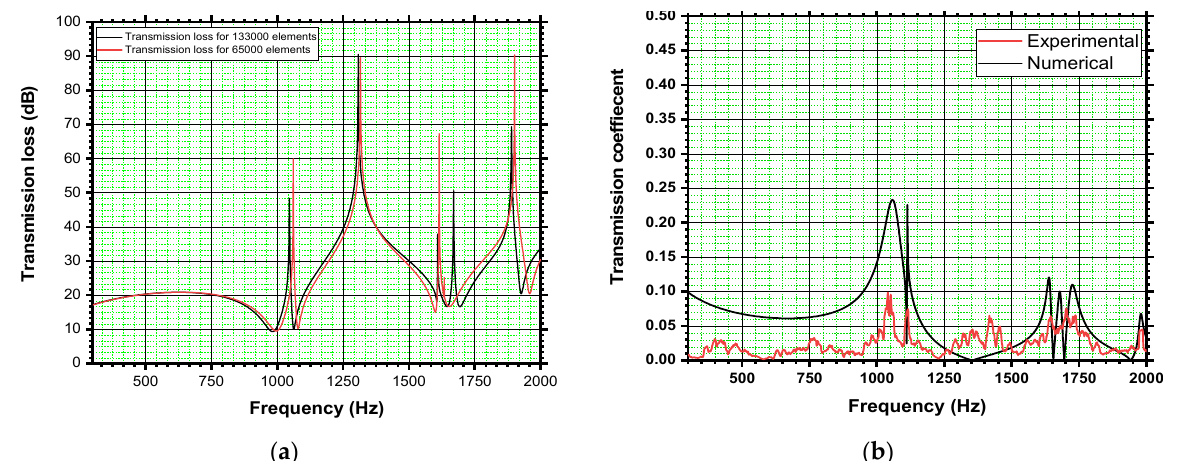
Figure 7. ( a ) Mesh convergence study to account system behavior accurately; ( b ) comparison of the experimental and numerical transmission coefficient curve.